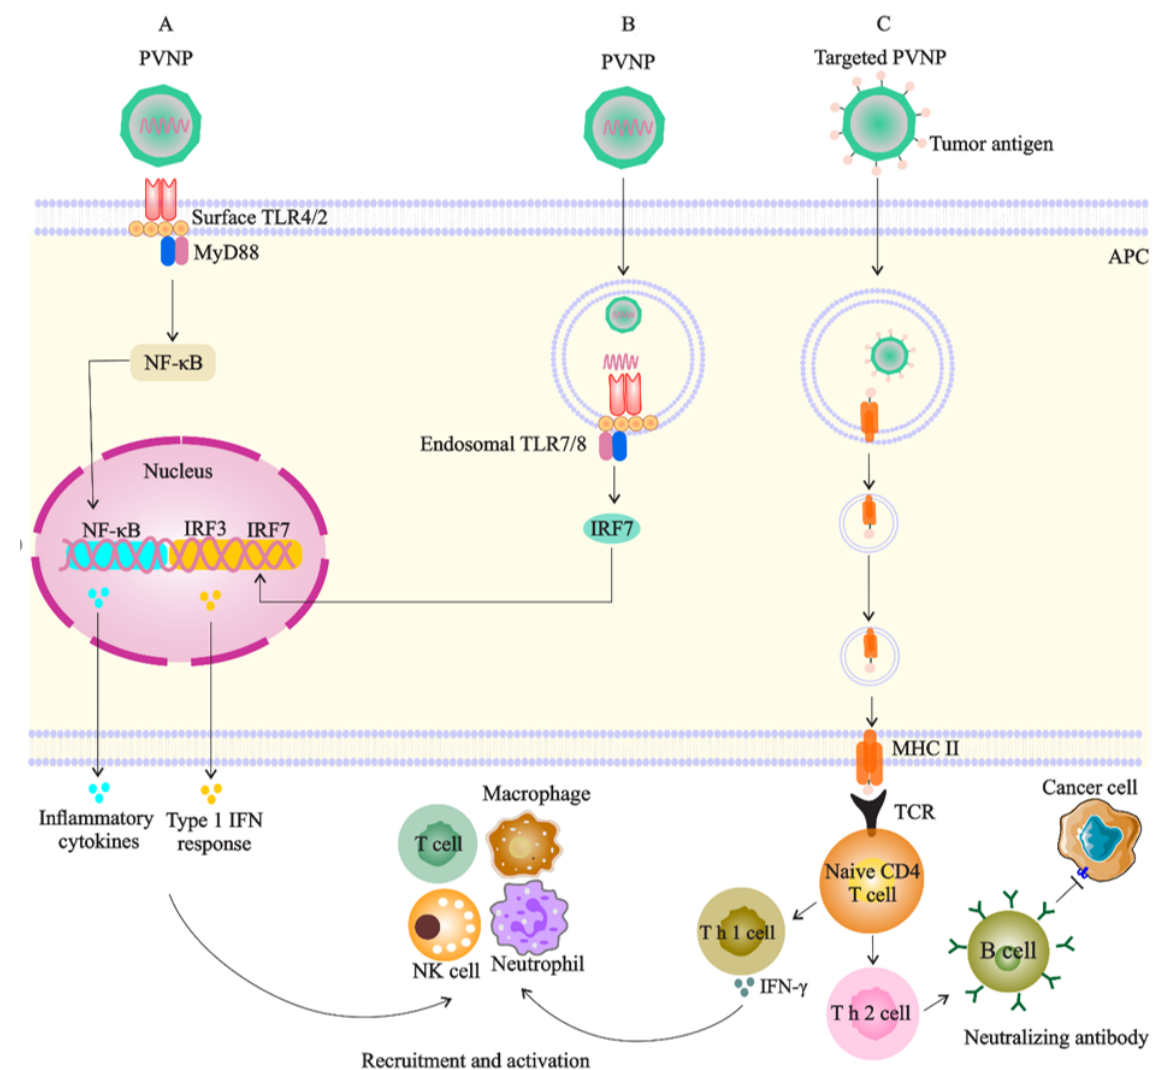
Figure 3. Targeted PVNP/VLP for immune cells (especial DC as APCs): ( A ). PVNP and VNP can bind to surface TLRs of APC and trigger the cytokine secretion to recruit and activate antitumor immune cells; ( B ). the genome of PVNP or VLP loaded with TRL agonists can bind to endosomal TLRs and induce interferon secretion; ( C ). cancer antigens display on the PVNP surface, and phagocytosis by APCs can induce anticancer immune reactions by activation of T cells or lead to the production of neutralizing antibodies against cancer antigens.